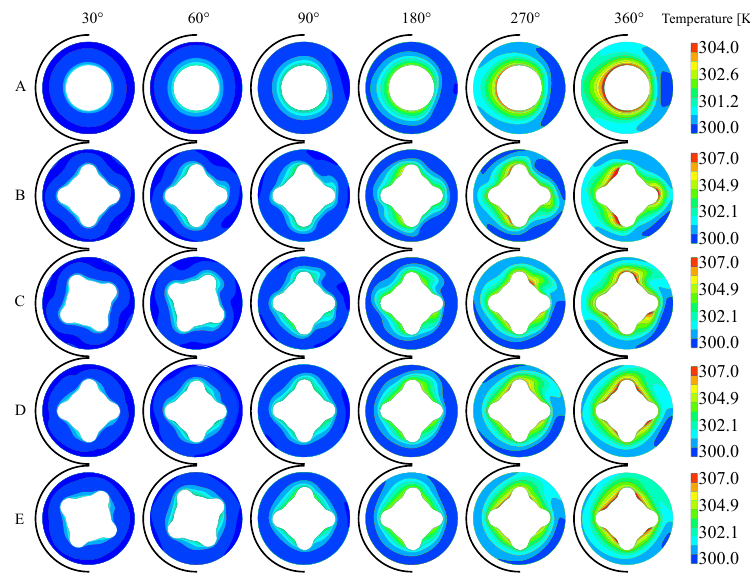
Figure 10. Temperature contours for the outer tube with Dean number 1000 for inner tube and with Dean number 4411 for outer tube. A: tube-in-tube. B: four ridges without twist. C: four ridges with 1 twist. D: four ridges with 3 twist. E: four ridges with 5 twist.